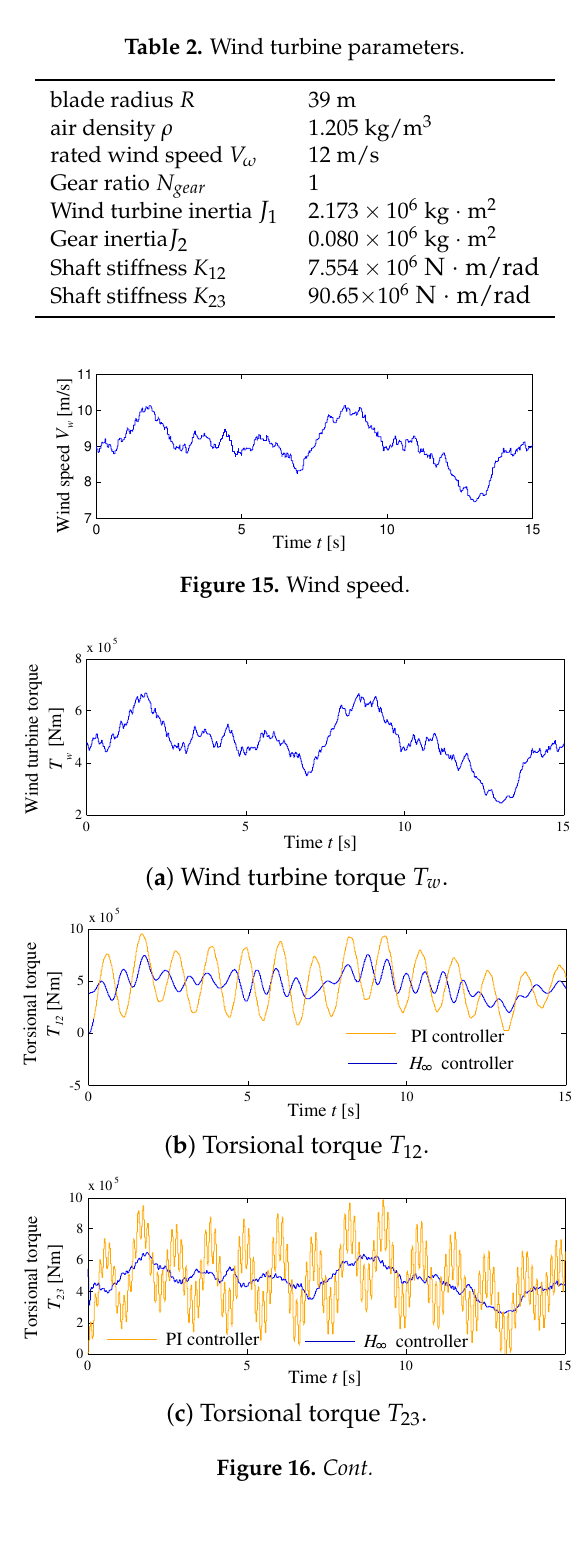
( c ) Torsional torque T 23 . Figure 16.